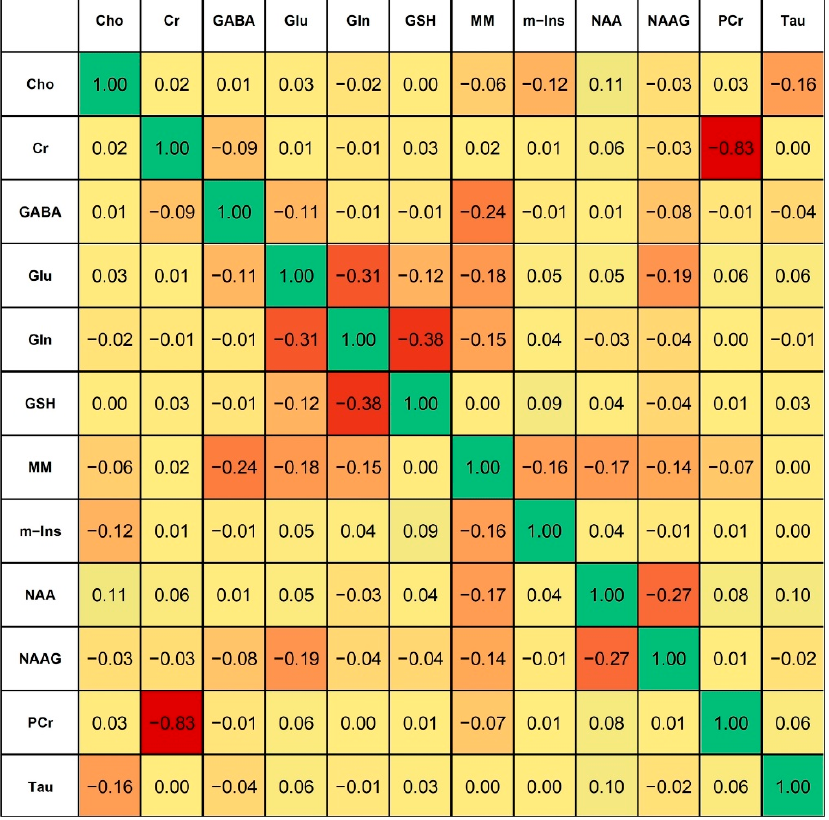
Figure 4. Correlations between neurometabolites quantified in vivo by MRS.